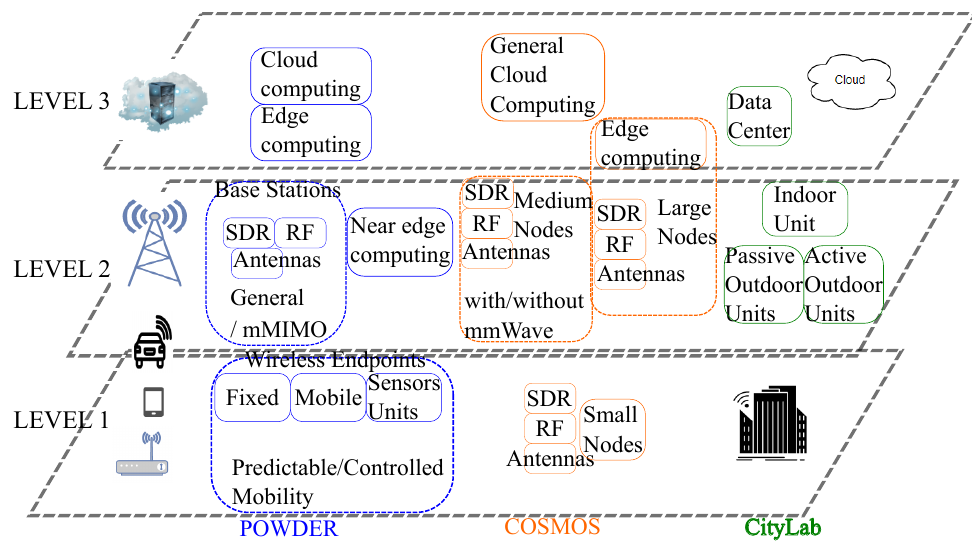
Figure 1. Overview of POWDER, COSMOS, and